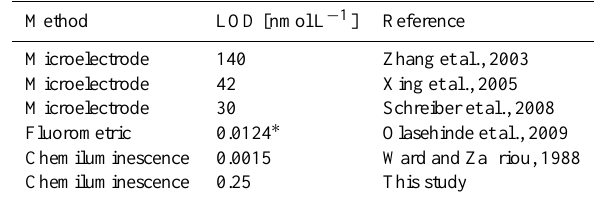
Table 1. Overview of published methods for NO detection in sea- water with the respective limit of detection (LOD) for each method.